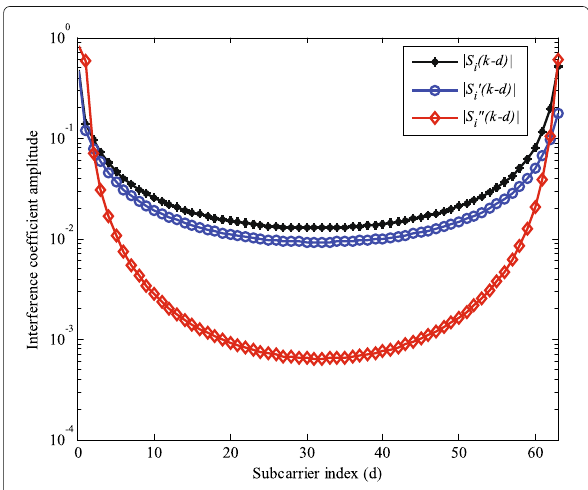
Fig. 3 A comparison among | S i ( k − d ) | , | S (cid:5) i ( k − d ) | and ( k − d ) | . This figure shows a comparison among | S (cid:5)(cid:5) i